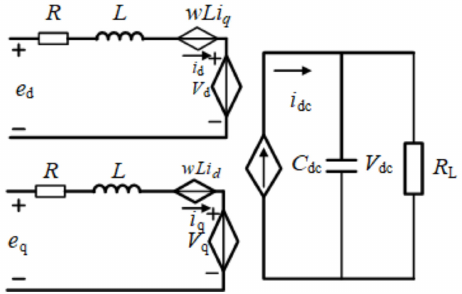
Figure 7. Equivalent model of PWM